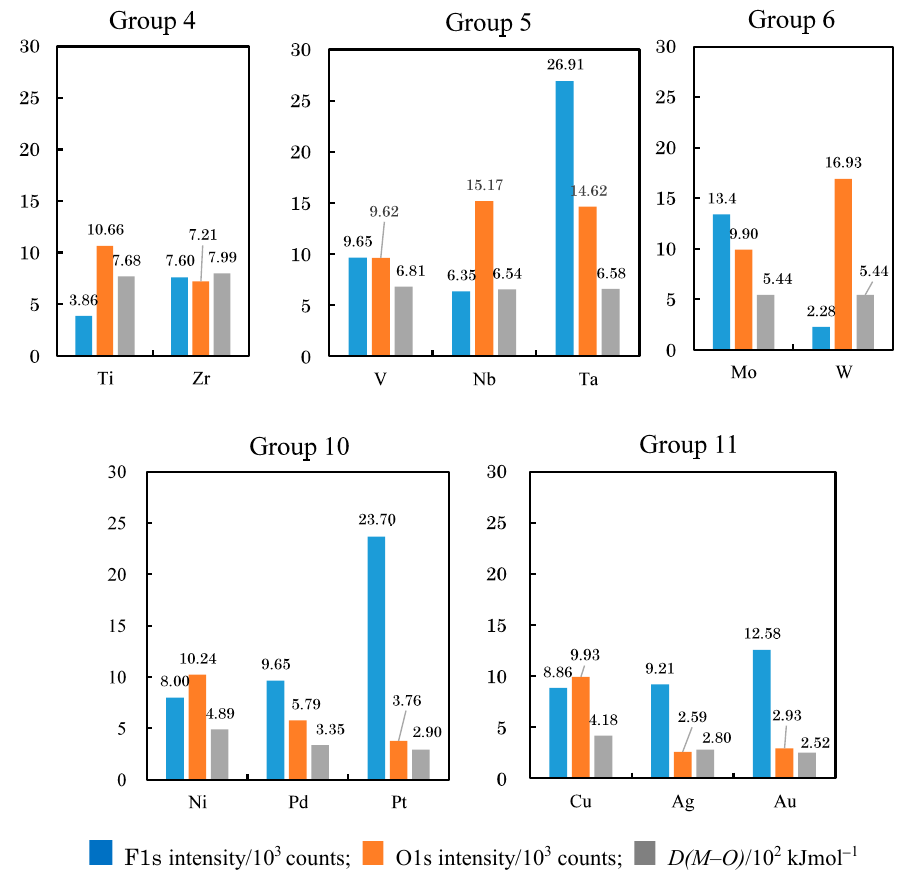
Figure 15. The relationship between D(M–O) values and XPS intensities of F1s and O1s after TriboEE measurement for metals in groups 4, 5, 6, 10, and 11.